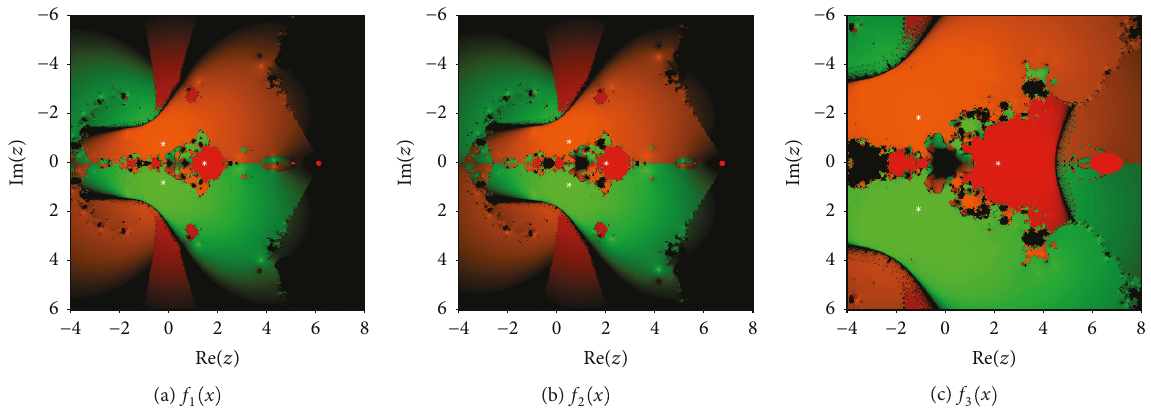
Figure 5: Dynamical planes of OM10 on test